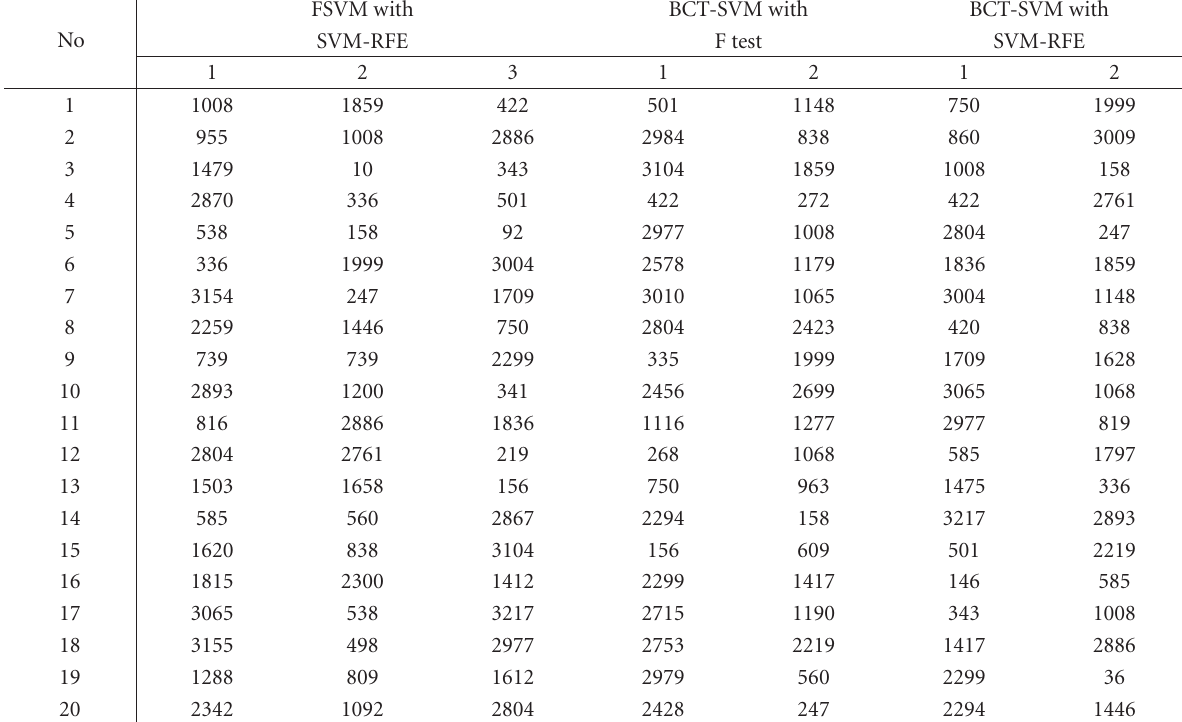
Table 1. The index no of the strongest genes selected in hereditary breast cancer dataset.